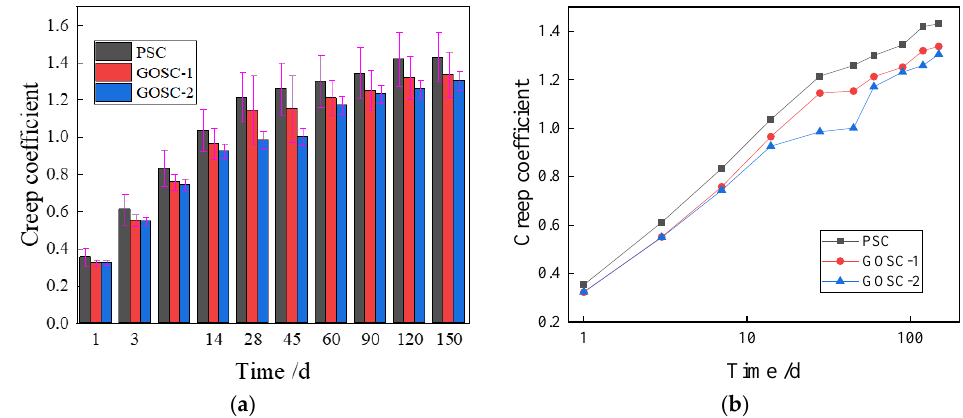
Figure 5. Changes of concrete creep coefficient with time. ( a ) Variability of creep coefficient; ( b ) trend graphic in which the age of the concrete uses a logarithmic scale.